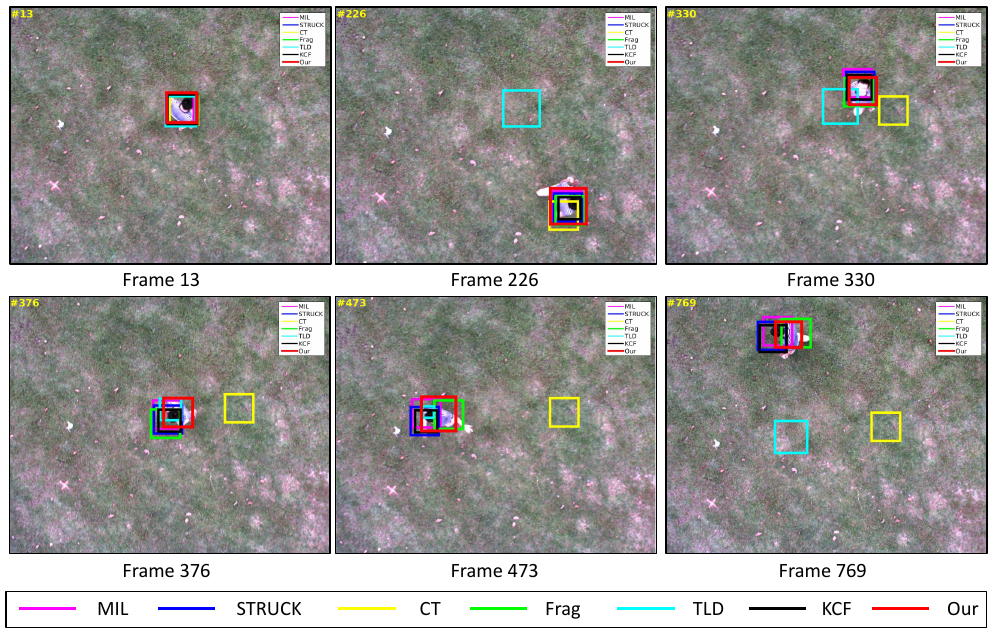
Figure 22. Some tracking results in the People bw image sequence. The total number of frames: 934.